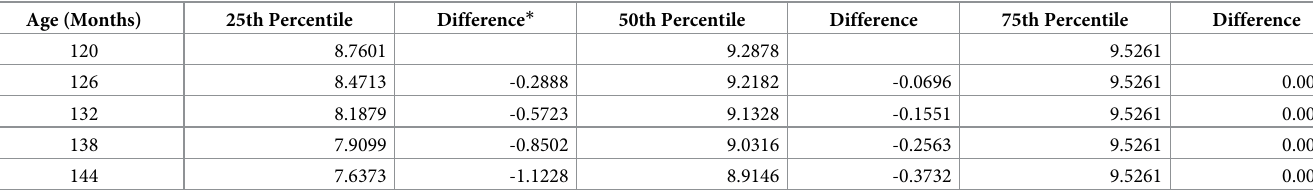
Table 1. Virtual controls’ sample percentiles associated with various ages and psych